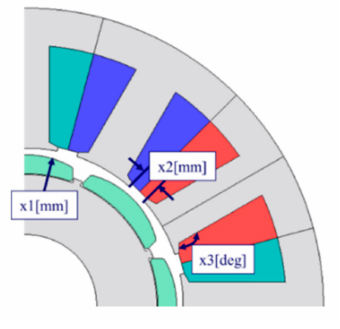
Figure 7. Selection of design variables. Table 1. Selection of design variables with their